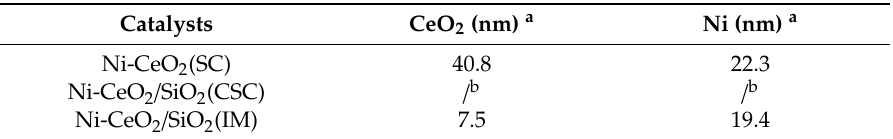
Table 2. Crystal size of the reduced catalysts.